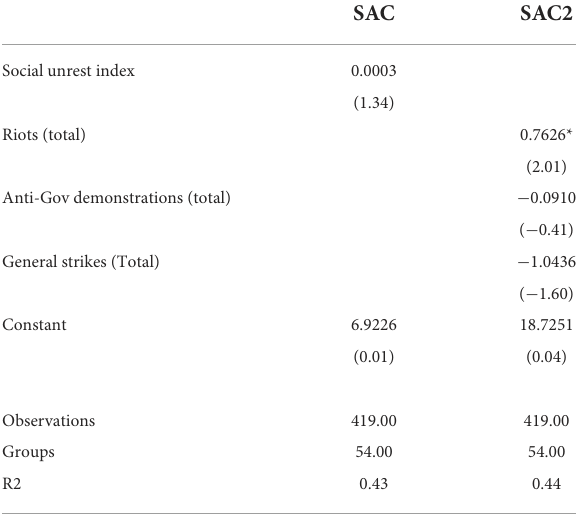
TABLE 2 Social assistance coverage and social